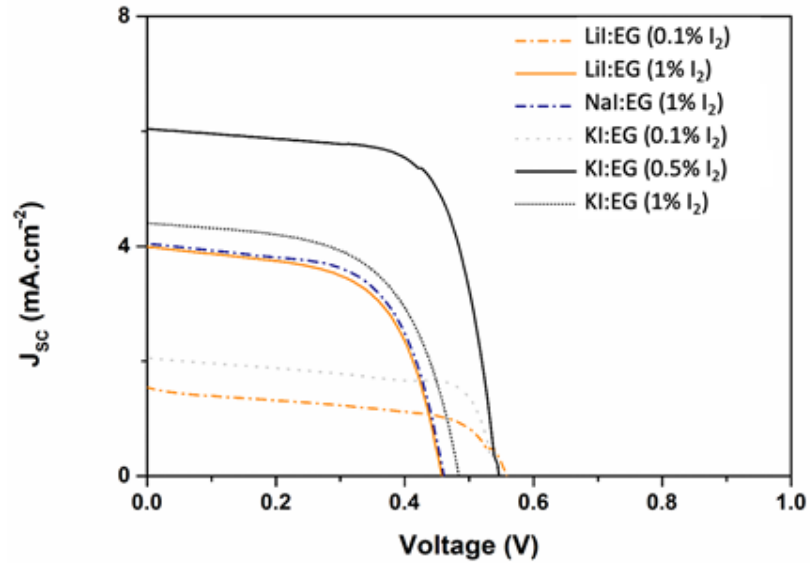
Figure 2. Photocurrent–voltage (J–V) curves of DSSCs based on dye N719 for the different alkali eutectic mixtures as electrolyte under 100 mW · cm − 2 simulated AM 1.5 illumination (for all prepared alkali eutectic mixtures with different mol % of iodine). Table 1. Photovoltaic performance parameters of DSSCs based on dye N719 for the different alkali eutectic mixtures as electrolyte, under 100 mW.cm −2 simulated AM 1.5 illumination. (The results presented are for the best performing cell). Electrolyte